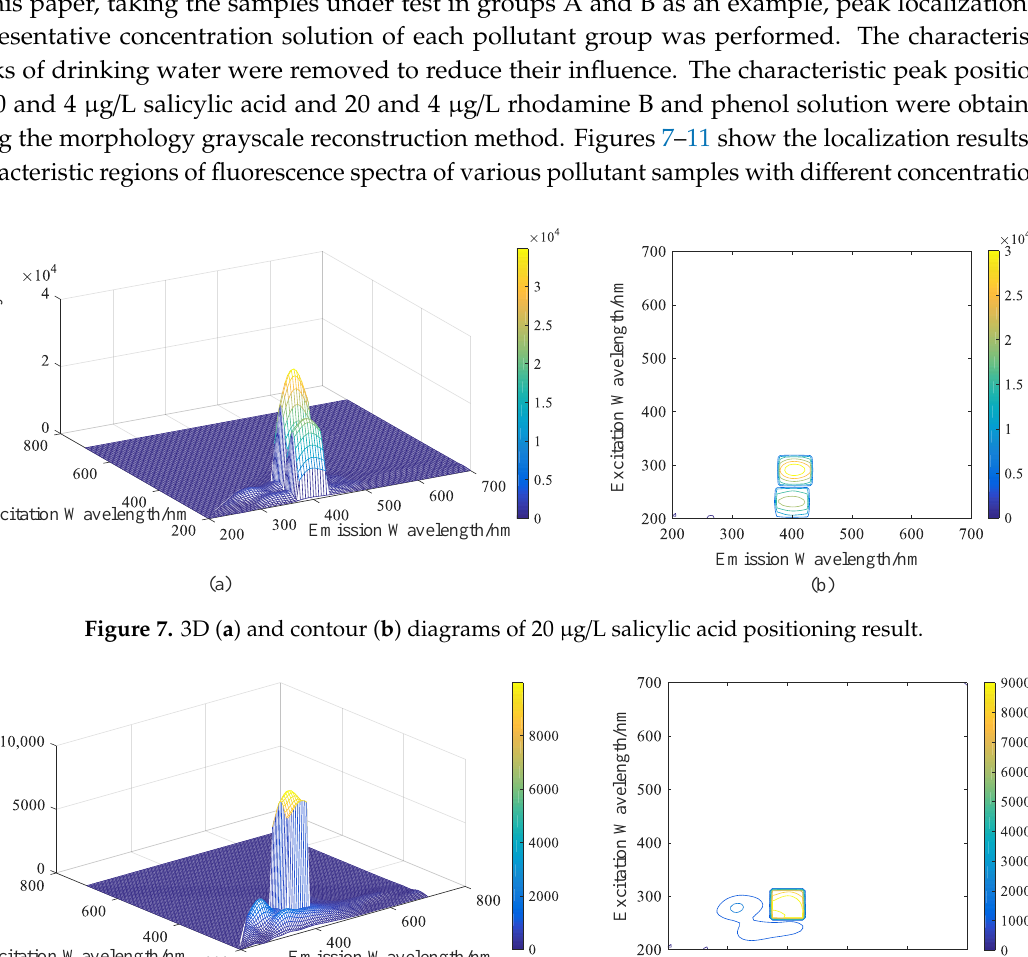
Table 9. Qualitative discrimination results of di ff erent concentrations without the improved algorithm.